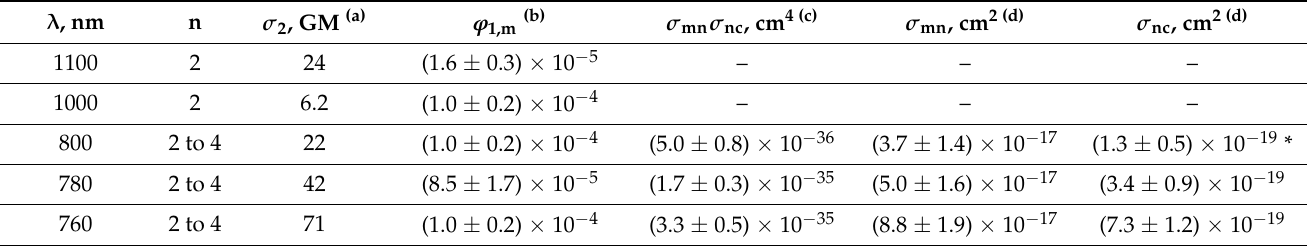
Table 1. Molecular photobleaching parameters of mCherry at different